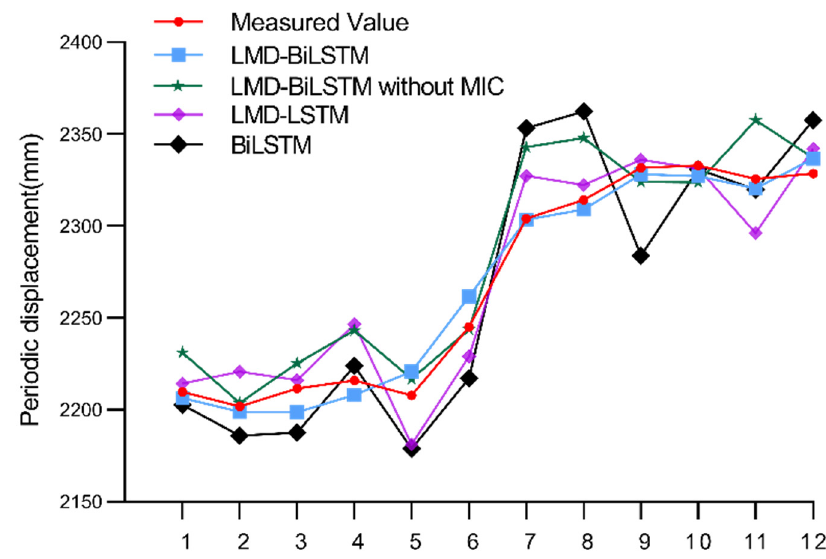
Figure 10. Final prediction results for the landslide displacement of four models.